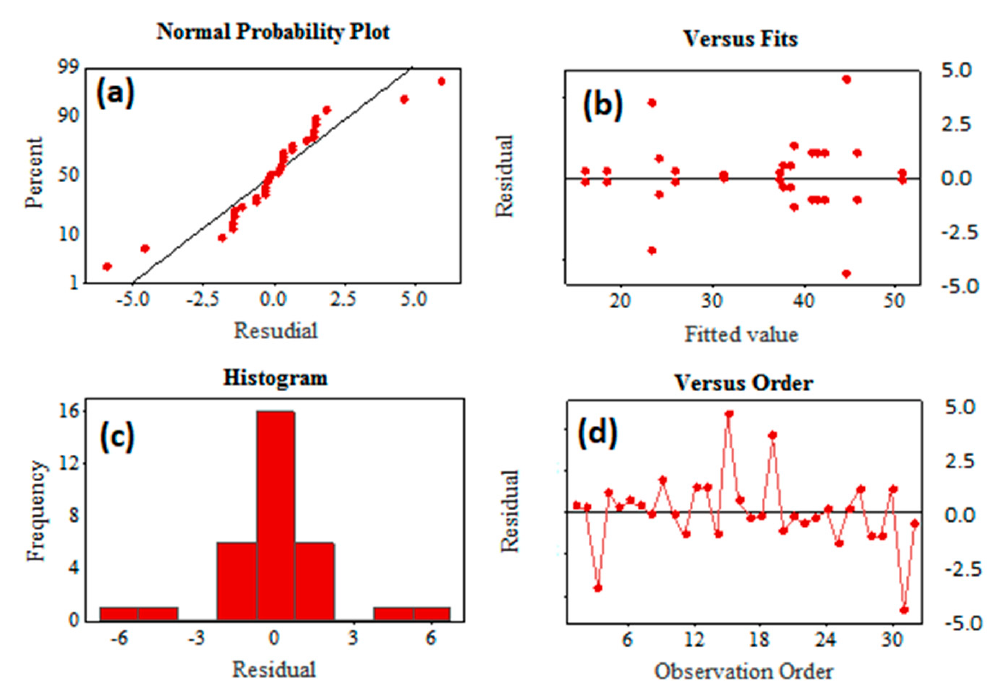
Figure 3. Validation indicator plots of the model for the experiments ( a ) Normal probability plot, ( b ) Versus fits ( c ) Histogram and ( d ) Versus order.